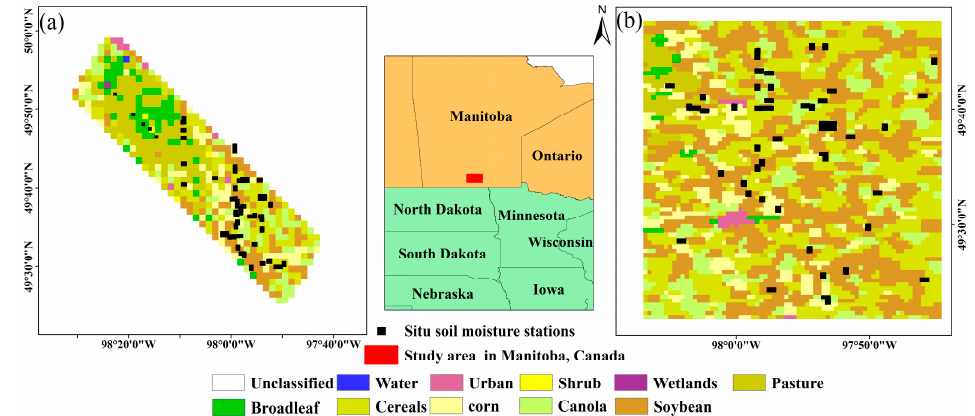
Figure 1. Spatial distribution and land cover type of ( a ) SMAPVEX12 and ( b ) SMAPVEX16-Mani- toba.